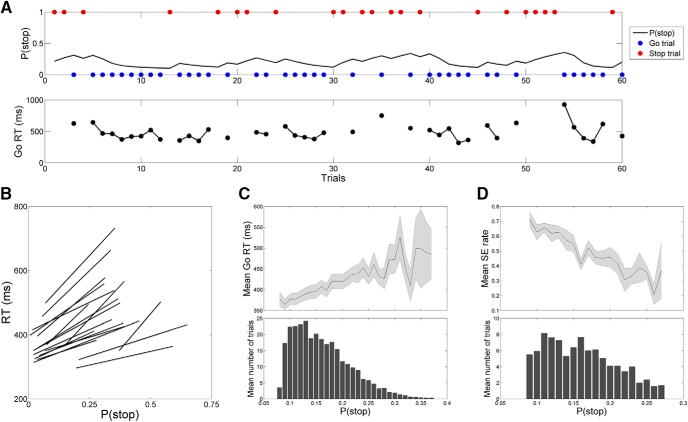
Bayesian model prediction of behavioral performance in the stop-signal task. A, Example sequence of trials. The upper panel shows the sequence of go (blue dots) or stop (red dots) trials and how Bayesian belief about encountering a stop trial [P(stop), black line] increases and decreases, respectively, after each stop and go trial. The lower panel shows the sequence of go-RT in the upper panel. Overall, go-RT tended to be prolonged with a higher P(stop). B, Correlation between P(stop) and RT across all go success trials, with each regression line representing an individual participant. C, Positive correlation between go-RT and P(stop) collapsed over all participants. The plot in the upper panel shows the mean ± SE, the histogram in the lower panel shows the distribution of P(stop), and both were binned at intervals of 0.01. D, Negative correlation between stop error (SE) rate and P(stop), with the same format as in C.